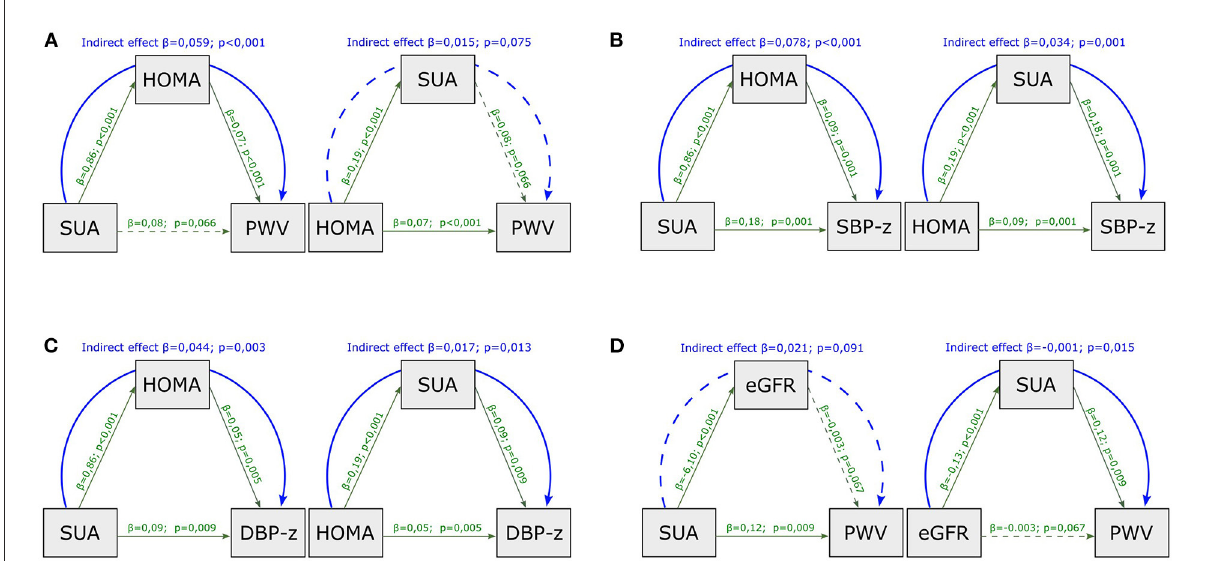
FIGURE1 Mediation analysis model with PWV as outcome, including HOMA-index and SUA as mediators (A) , with SBP (B) and DBP (C) z- scores as outcome, including HOMA-index and SUA as mediators and with PWV as outcome including SUA and eGFR as mediators (D) . SUA, serum uric acid; HOMA-index, homeostatic model assessment index; PWV, pulse wave velocity; eGFR, estimated glomerular filtration rate; SBP-z, systolic blood pressure z- score; DBP-z, diastolic blood pressure z- score. Continuous line, statistically significant; dotted line, not statistically significant; green line, direct effect; blue line, indirect effect.